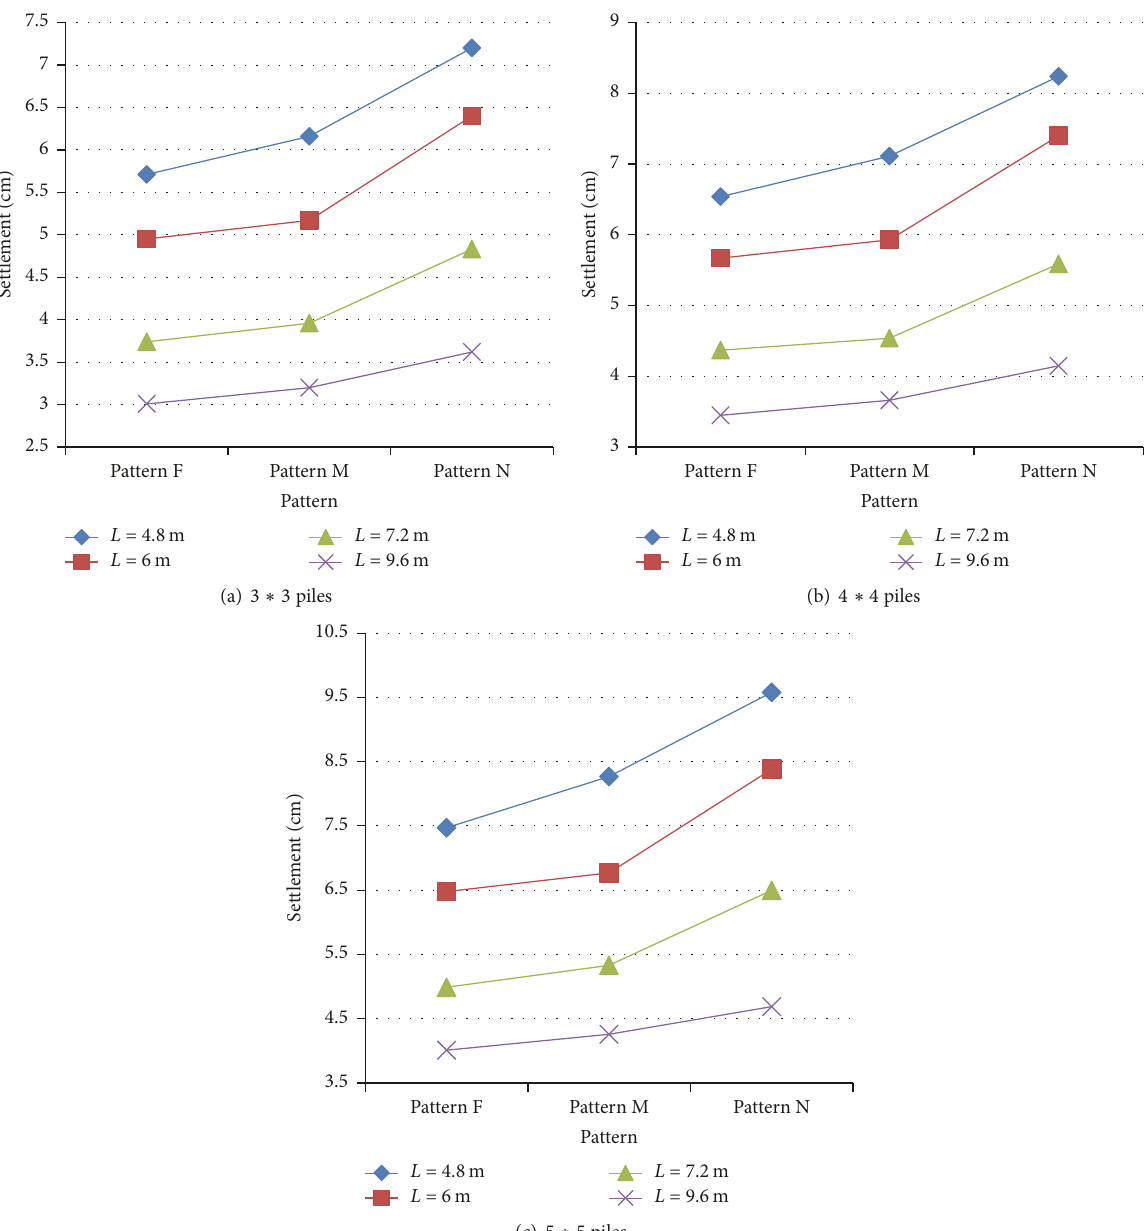
Figure 13: Effect of piles’ length on the coupled static-dynamic settlements of CPRF ( 𝑑 = 0.5 m, 𝑝 = 60 kPa).